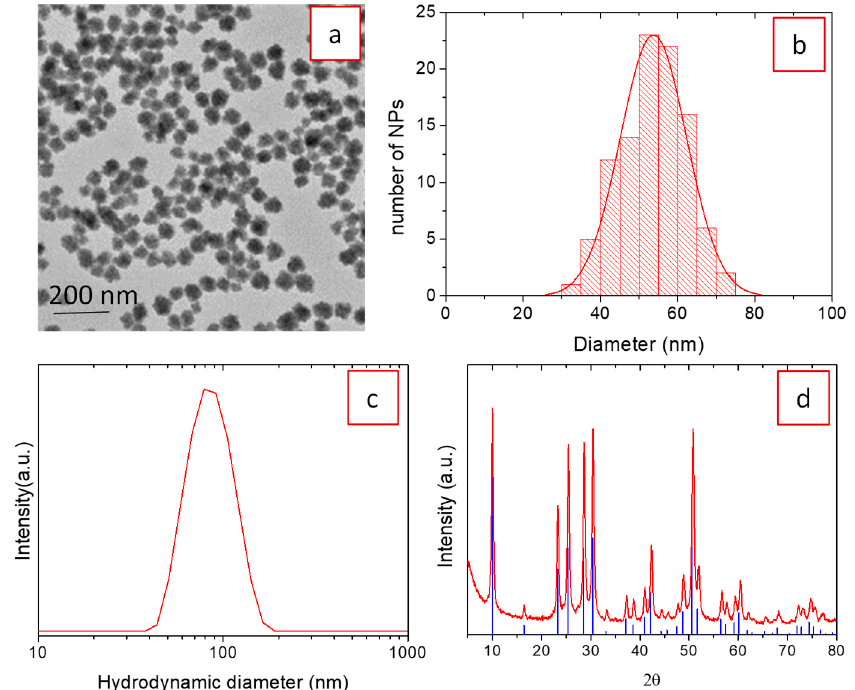
Figure 1. TEM micrograph ( a ), particle size distribution from TEM ( b ), dynamic light-scattering (DLS) curve ( c ), and XRD pattern ( d ) of nanoparticles obtained after treating, at 50 °C for 15 h, an EG/H 2 O (90 / 10) solution containing Lu(NO 3 ) 3 · 6H 2 O (0.2 M) and NaBF 4 (0.18 M). Ticks at the bottom of (d) correspond to cubic (H 3 O)Lu 3 F 10 (PDF 04-016-7065).